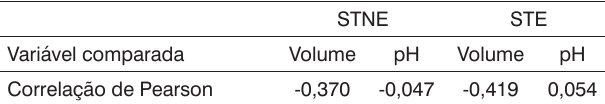
Tabela 2. Valores do índice de correlação de Pearson na com- paração entre a idade dos indivíduos e as variáveis salivares estudadas, nas amostras de saliva total não estimulada (STNE) e saliva total estimulada